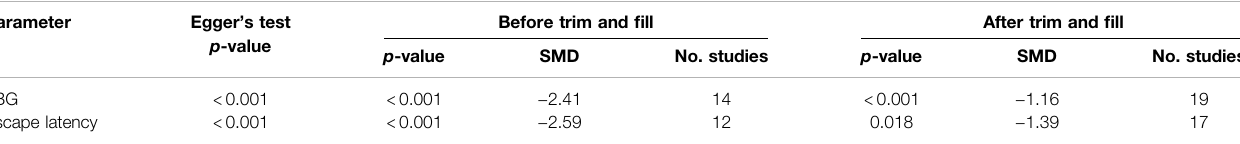
TABLE 5 | Results from Egger ’ s test and trim and fi ll